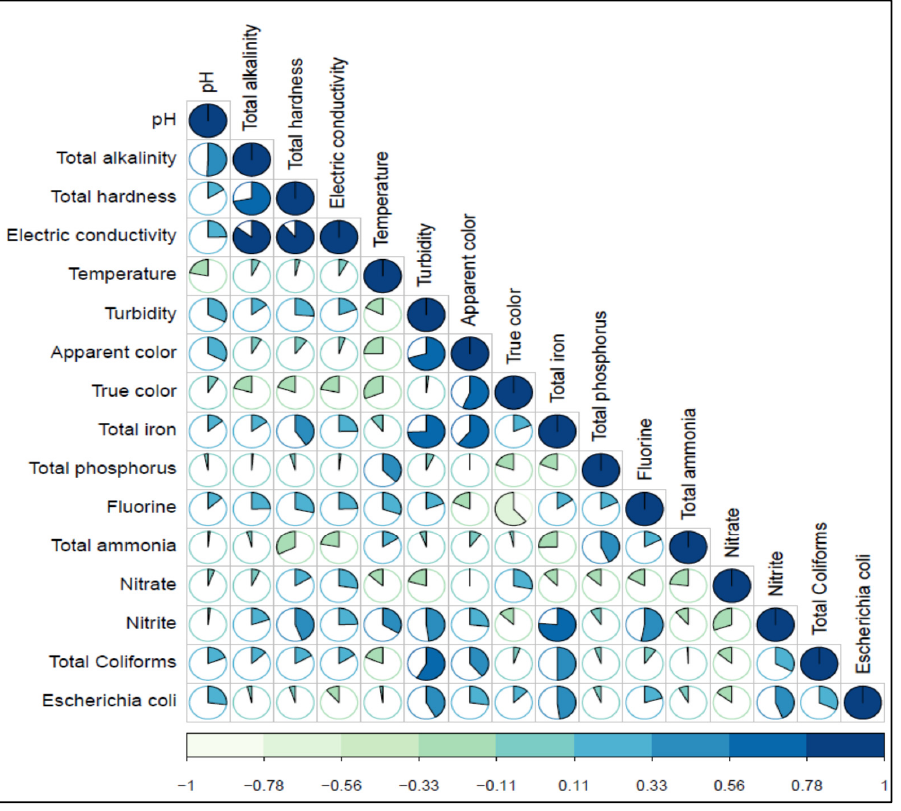
Figure 2. Pearson linear correlations among chemical, physical, specific chemical, and microbiological variables of springs. Variables in dark blue have a strong positive correlation and those in light green have a strong negative correlation.